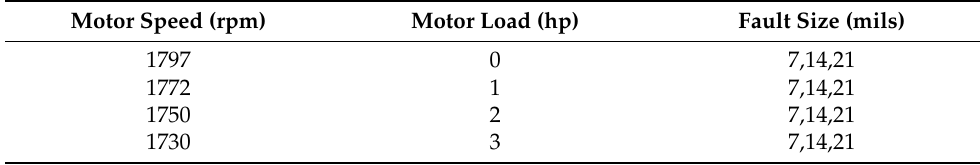
Table 3. Introduction of experimental data sets under different load